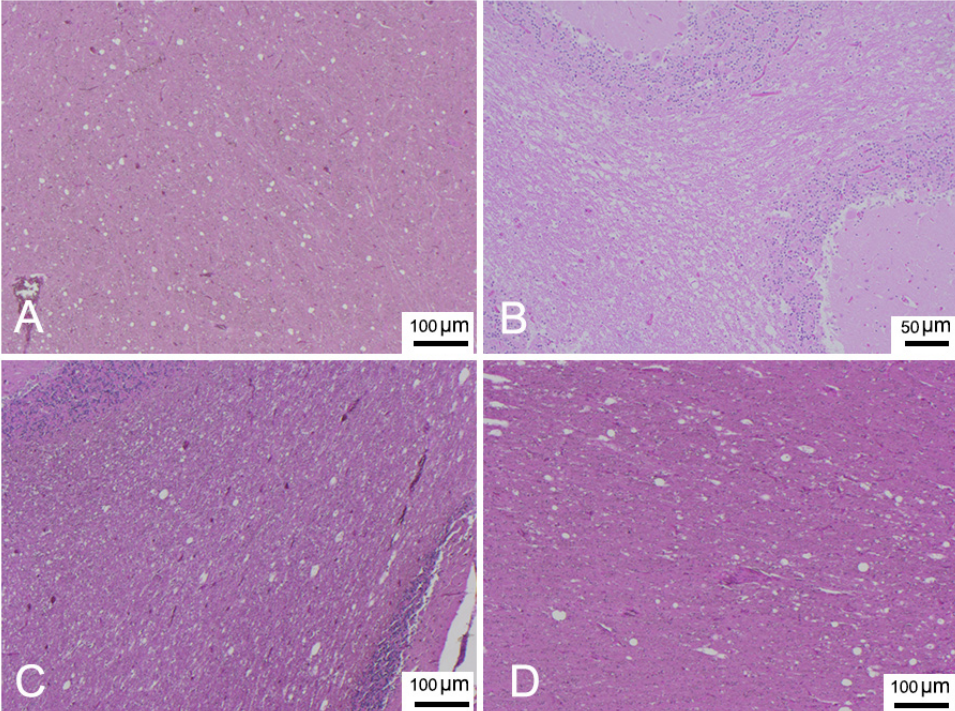
Figure 3. ( A ) Parietal cortex (ID 9). Spongiosis in white matter. HE. ( B ) Cerebellar cortex (ID 10). Severe myelinopathy, HE. ( C ) Occipital cortex (ID 28). Spongiosis in white matter. HE. ( D ) Cerebellar cortex (ID 28). Spongiosis in white matter. HE.